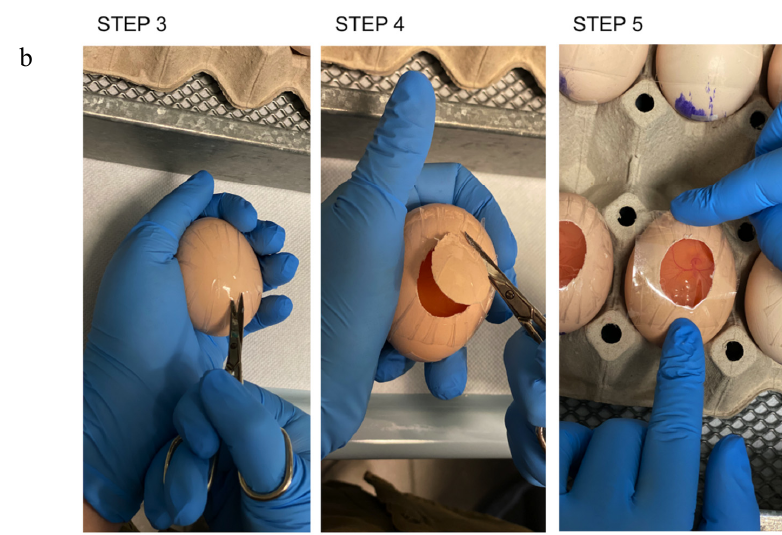
Figure 1. Handling of eggs: ( a ) manipulation of the egg to suck the albumen; ( b ) opening of the shell, exposure of the chorioallantoic membrane (CAM) for the implants, and closing with tape.